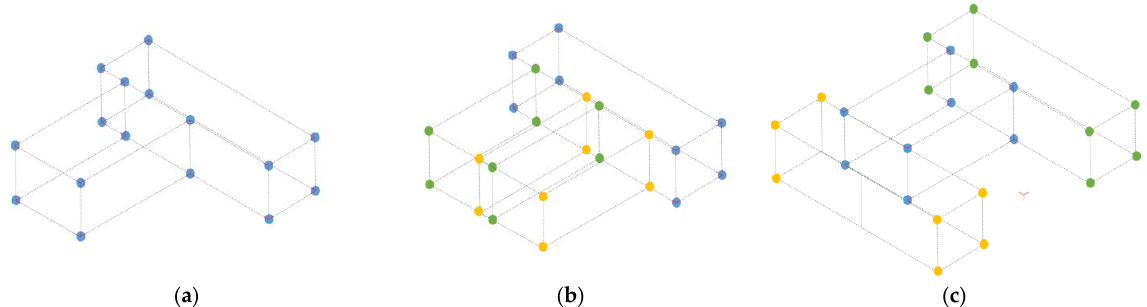
Figure 11 . Visualization of the corner points from the as-built (yellow) and transformed as-planned model (green) resulting in aligned corner points (blue) according to each cluster transformation ( a – c ).